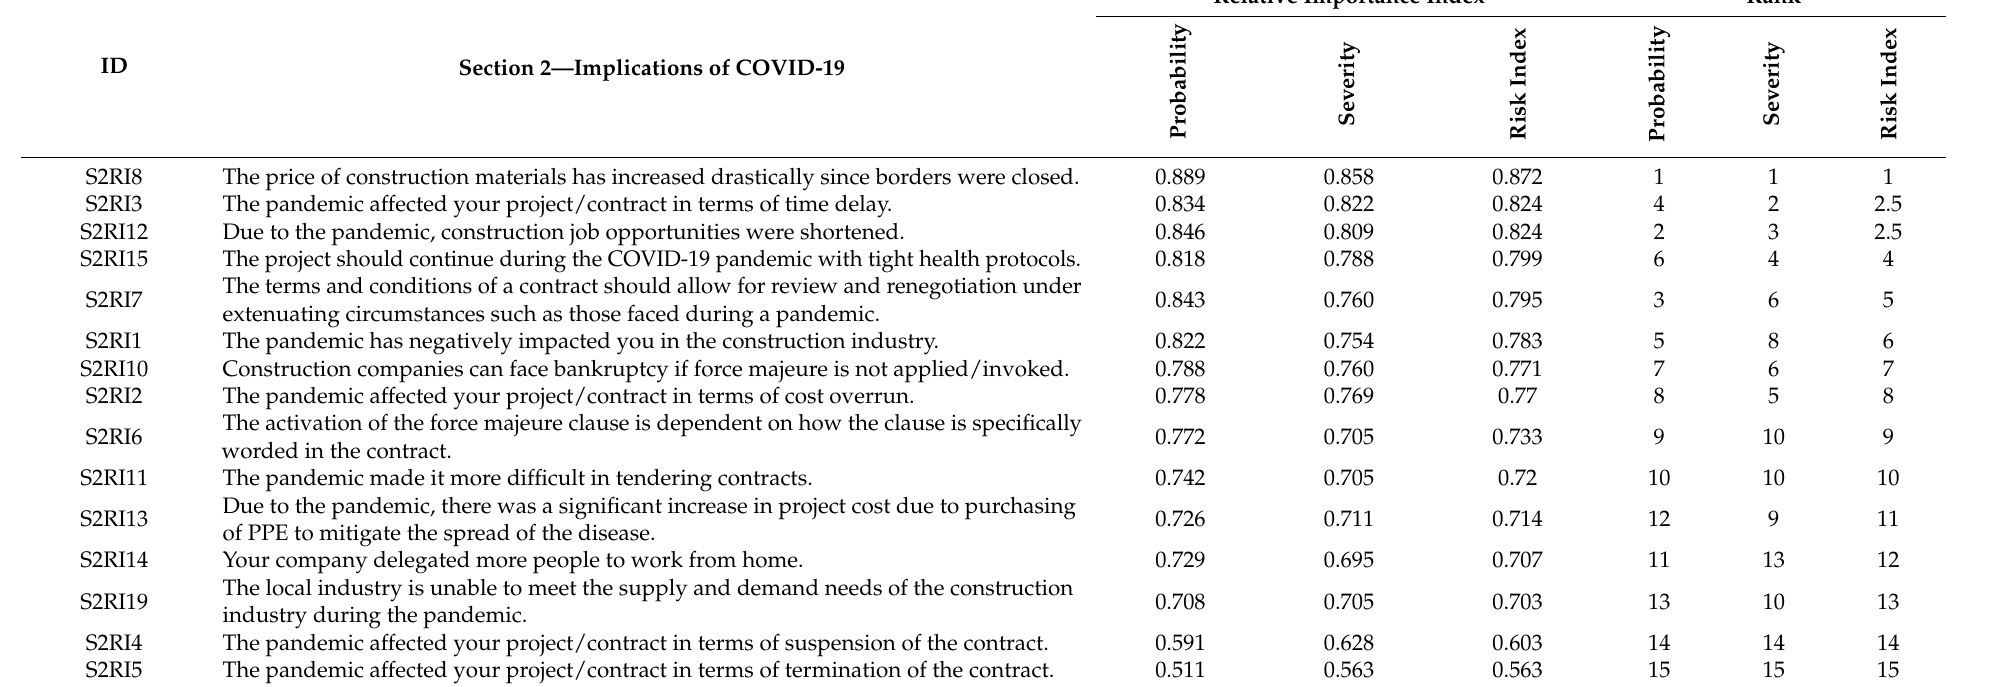
Table 5. The relative importance index and its ranking for the probability, severity, and risk index of implications of COVID-19.